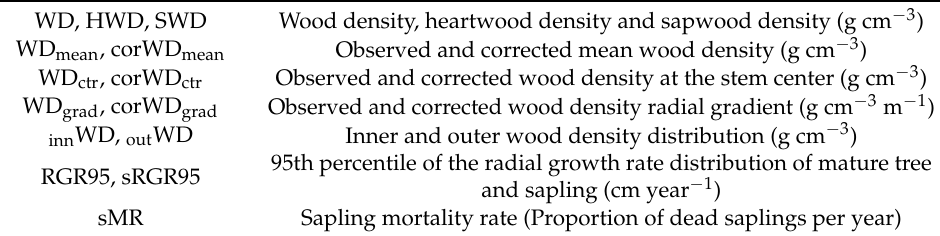
Table 2. List of variables measured and their